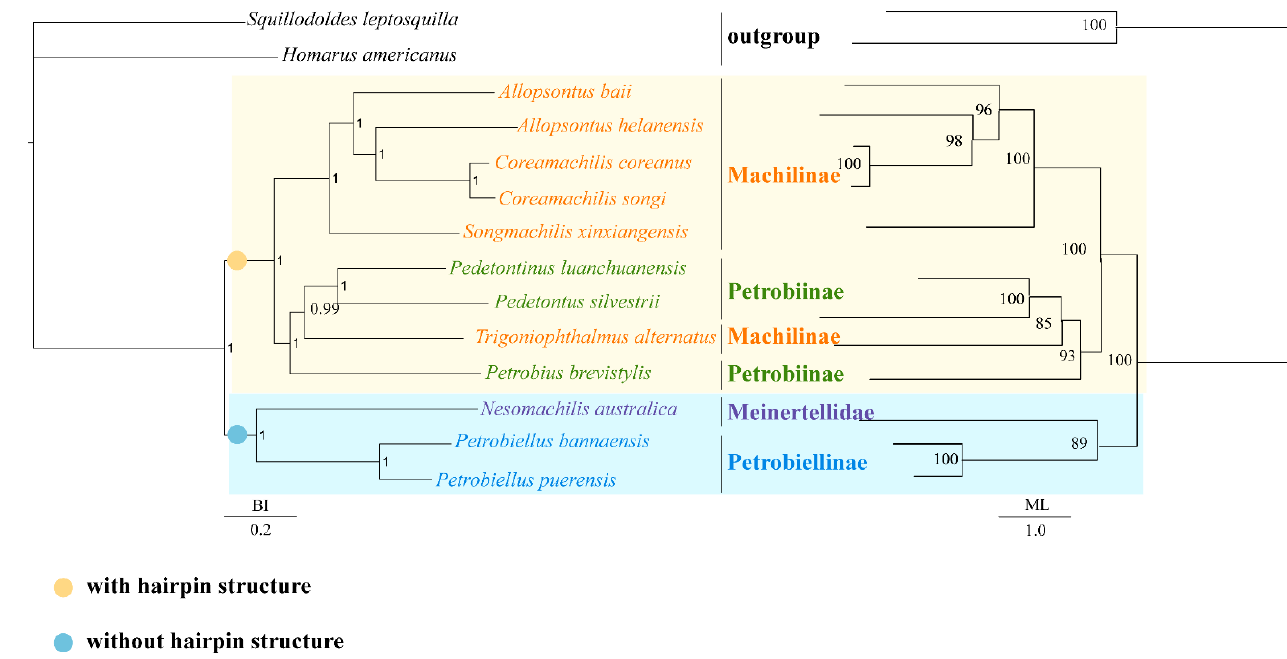
Figure 4. Phylogenetic relationships of Coreamachilis inferred from BI analysis ( left ) and ML analysis ( right ) based on 13 mitochondrial protein-coding genes including 12 Microcoryphia species. H. americanus and S. leptosquilla were used as the outgroup. The numbers above branches specify posterior probabilities as determined from BI ( left ) and bootstrap percentages from ML ( right ).